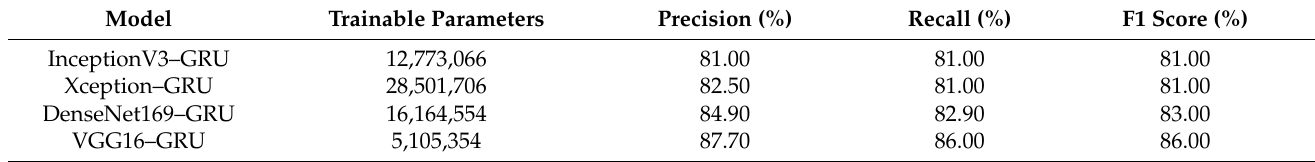
Table 8. Parameters and various accuracy measures of pretrained models.